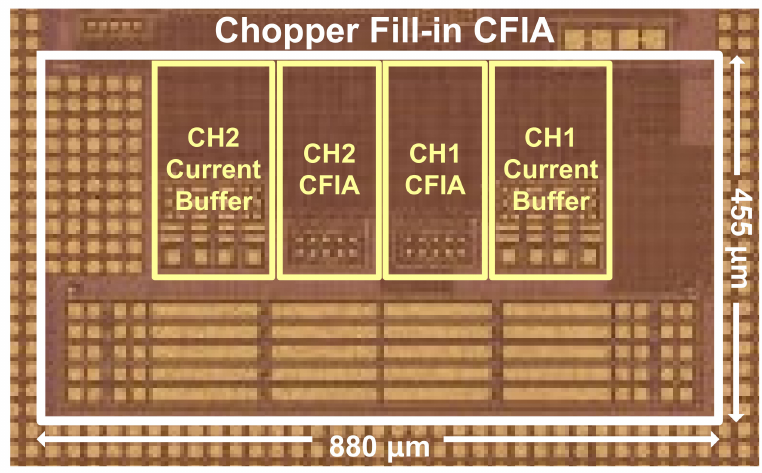
Figure 13. Die photograph of the proposed CFIA.